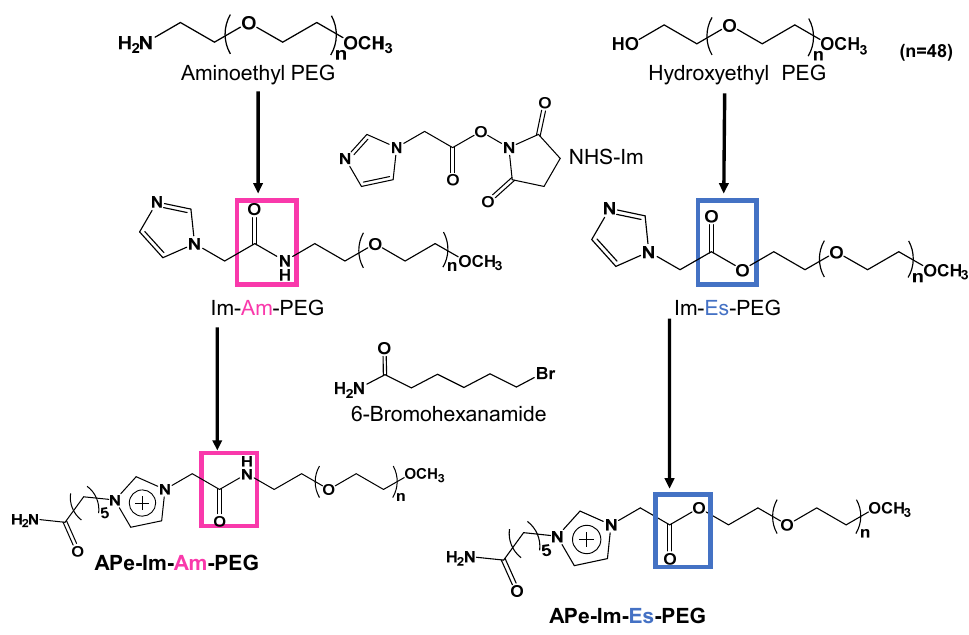
Figure 1. Synthesis scheme of APe-Im-Am-PEG and APe-Im-Es-PEG.